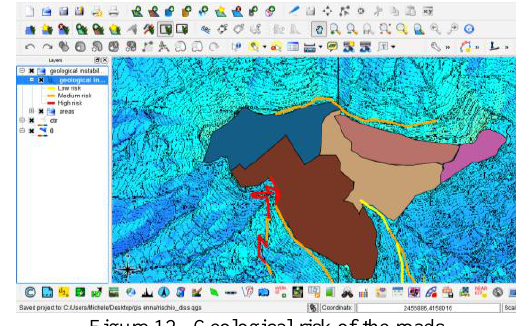
Figure 10. Road vulnerability due to soil instability